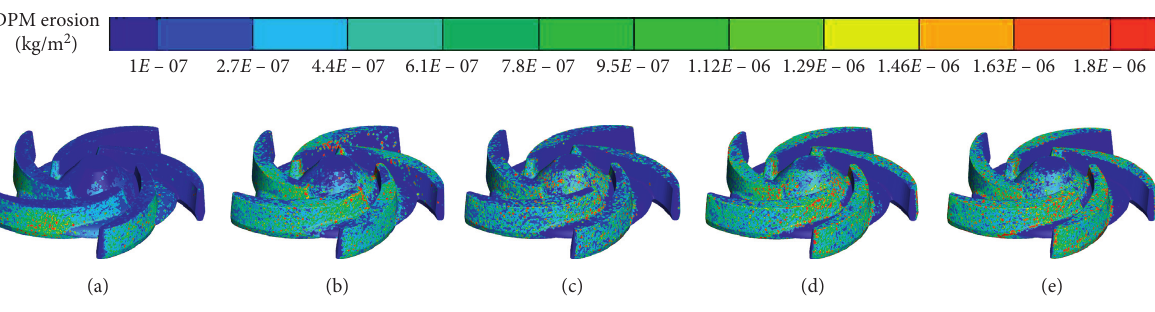
Figure 8: Impeller surface wear clouds at different particle sizes. (a) d � 0.048mm, (b) d � 0.106mm, (c) d � 0.15mm, (d) d � 0.27mm, and (e) d � 0.425mm.